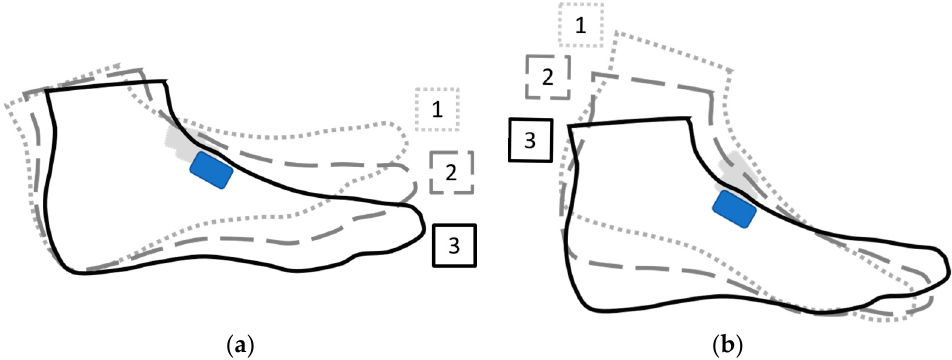
Figure 2. Examples of different foot strike pattern (FSP) and foot strike angle (FSA) classifications. Events: 1—Initial Foot contact; 2—Foot rotation 15 ms after 1; 3—Foot stationary on ground. Clockwise rotation defined as positive angle change, positive angular velocity. ( a ) LEFT HAND SIDE: FSP classification: rearfoot strike (RF)—average angular velocity between 1 and 2 is positive; FSA angle: positive—change in foot (sensor) angle between 1 and 3 is positive; ( b ) RIGHT HAND SIDE: FSP classification: nonrearfoot strike (NRF)—average angular velocity between 1 and 2 is negative.; FSA angle: negative—change in foot (sensor) angle between 1 and 3 is negative.